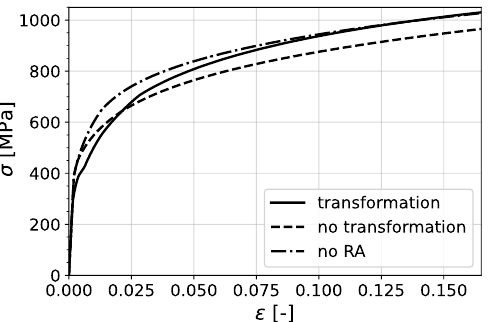
Figure 8. Simulation of uniaxial tension with and without transformation, where no transformation repre- sents the case with a very stable RA and no RA is the case where RA was replaced with initial martensite. Hence, in the case of non-transforming RA, the material lost the added ductility from transformation; however, since the flow stress was also reduced, it retained a high formability. On the other hand, the material without RA had high flow stress without the added ductility due to TRIP; therefore, it performed the worst. Therefore, it is clear that the material with transformation of RA benefited from transformation plasticity while keeping the high strength due to a complete transformation to